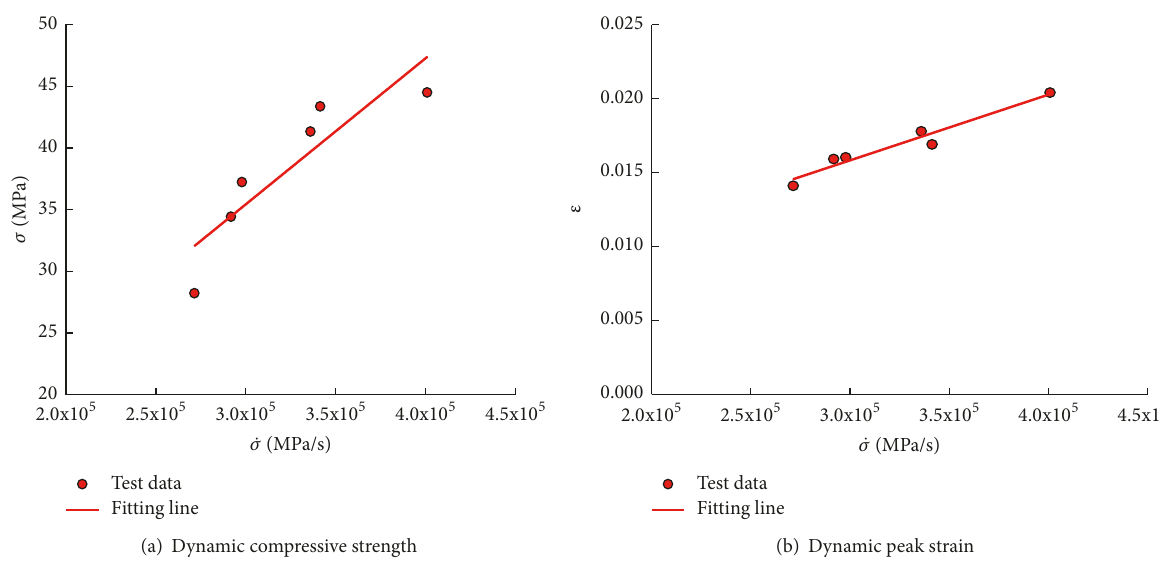
Figure 9: The relationship between dynamic compressive strength, dynamic peak strain, and loading